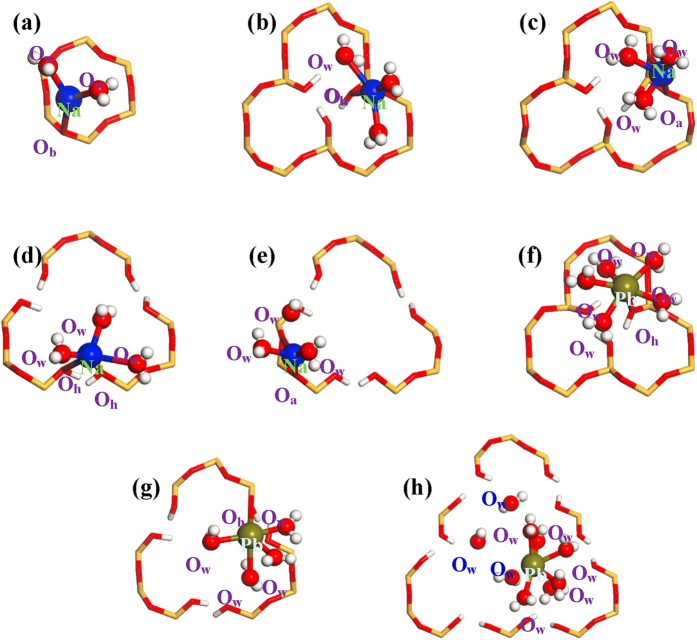
Local structures of inner-sphere Na+ and Pb2+ ions adsorbed on the tetrahedral SiO4 surfaces of regular (Si0) and defective kaolinite (Si1, Si2 and Si4).(a) for Si0(Na+), (a–c) for Si1(Na+), (a,d,e) for Si2(Na+) as well as (f) for Si1(Pb2+), (g) for Si2(Pb2+) and (h) for Si4(Pb2+), respectively. Note that Si4(Pb2+) is actually for quasi inner-sphere Pb2+ ions adsorbed on the water molecules within the silanol nests of Si4.